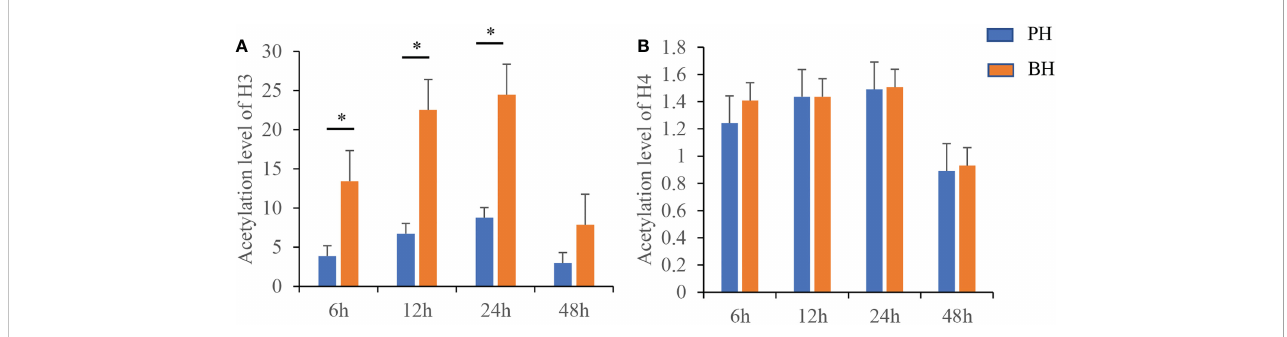
FIGURE 1 Changes of histone H3 and H4 acetylation at different time points after butyrate stimulation. (A) the level of Histone H3 acetylation in the PH/BH group. (B) the level of Histone H4 acetylation in the PH/BH group. Blue is the PH group and red represents the BH group. Values were shown as mean ± SD (N = 3), * P <